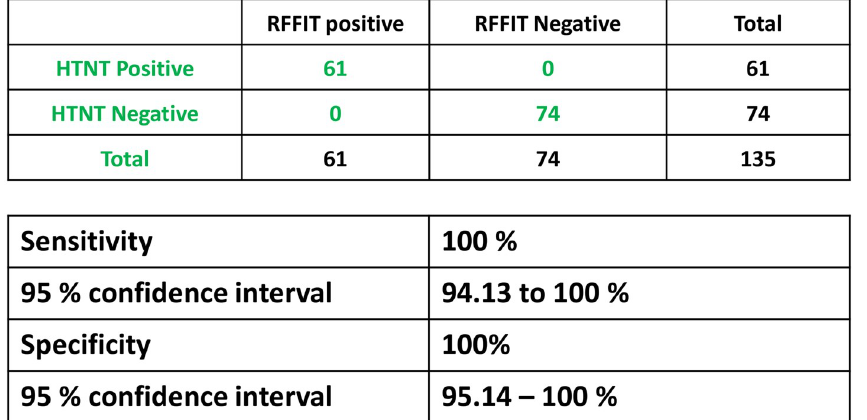
Fig 3. Sensitivity and specificity of human sera. Neutralization capability of rabies-specific antibodies in sera from vaccinated and na ï ve individuals was assessed using RFFIT and HTNT. Based on the complete neutralization of RABV at the 1:5 serum dilution samples were classified as positive or negative. Sensitivity and specificity of HTNT assay for detection of rabies VNAs were calculated based on the RFFIT results and tabulated with 95% confidence interval levels.